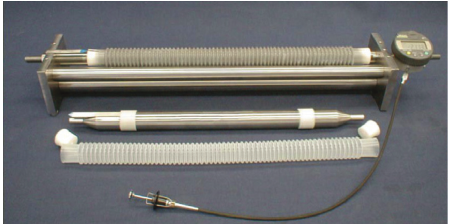
Figure 1: Schematic diagram of autogenous shrinking instrument